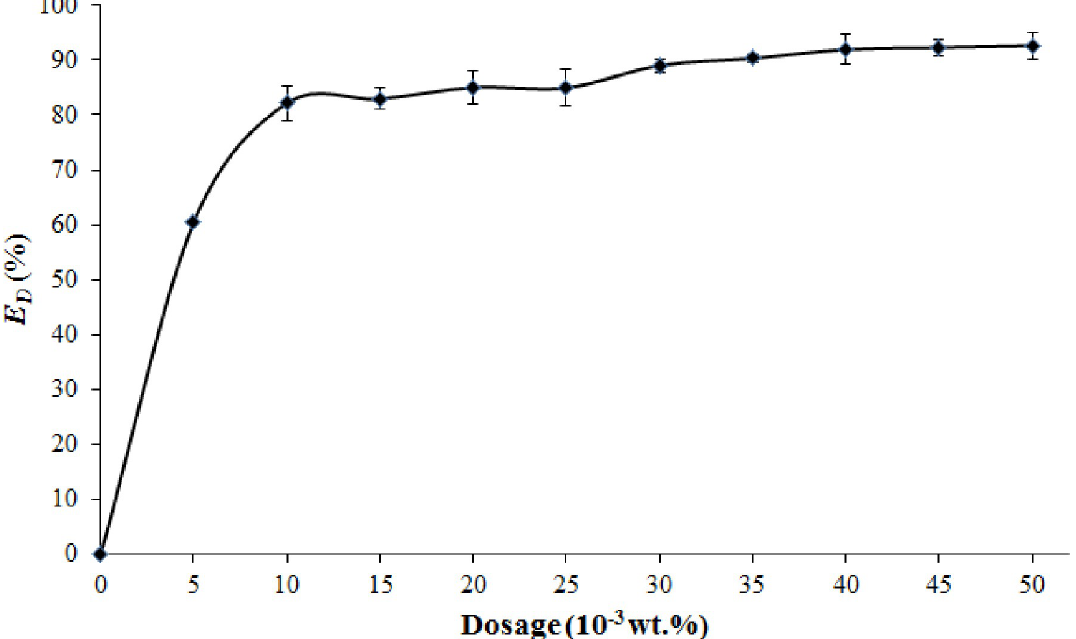
Fig 10. Effect of M-rGO nanocomposites dosage on E D for crude O/W emulsion.